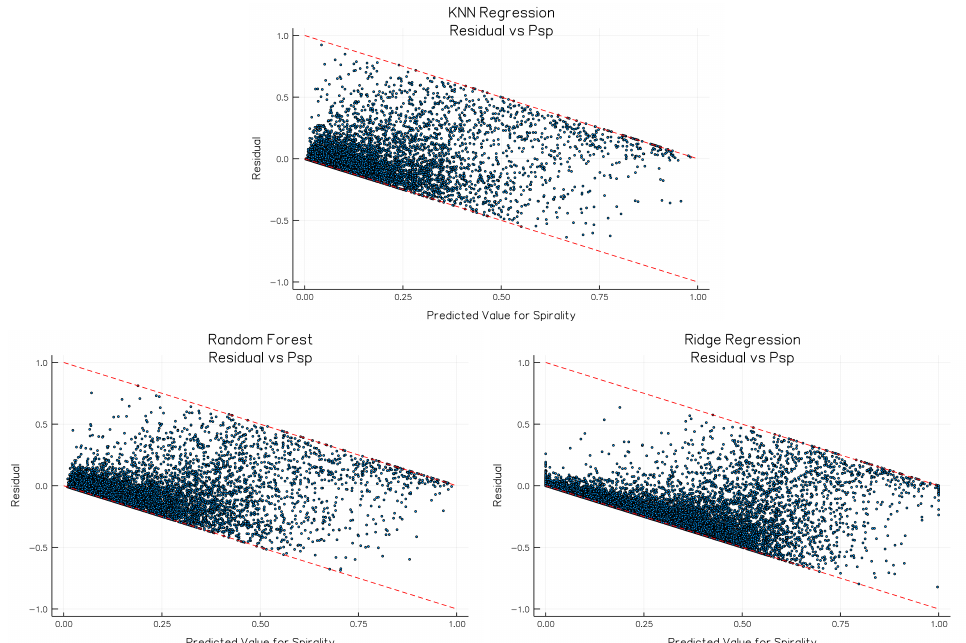
Figure 8. Residual plots for models trained with both SDSS features and SpArcFiRe features. For visualization purposes we used only 10,000 points from the test set for these plots. The red dashed lines indicate the possible bounds that the values can fall on. Since both the inputs and outputs are constrained to be in the interval [0, 1] (cf. Figure 5), the lower bound is determined by f ( x ) = − x and the upper bound is determined by f ( x ) = − x + 1, for 0 ≤ x ≤